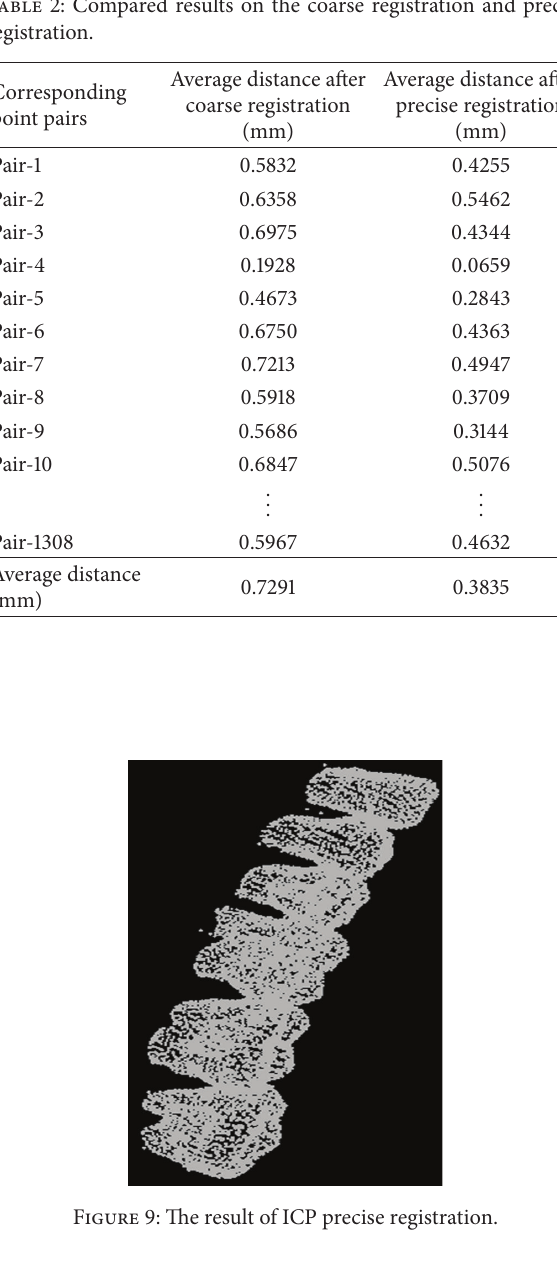
and the average distance of corresponding points is calcu- lated. For the first experiment the average distance of the coarse registration, shown in Table 2, is 0.7291 mm while it is reduced to 0.3835 mm after precise